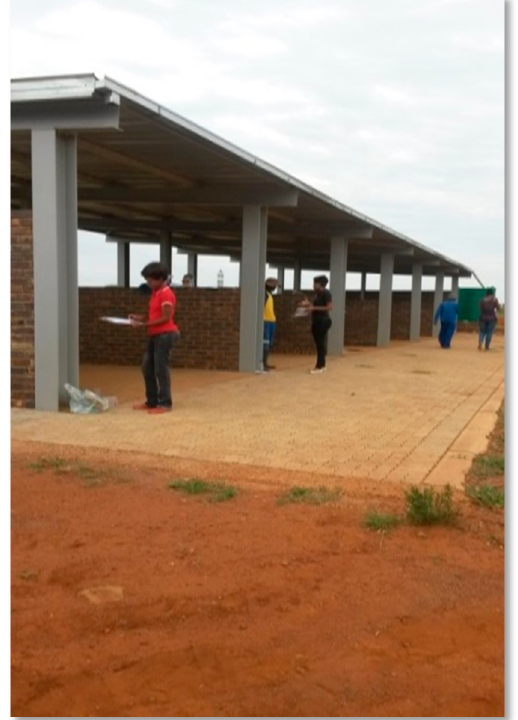
Figure 7. Shade provided on a landfill. Source: Authors.